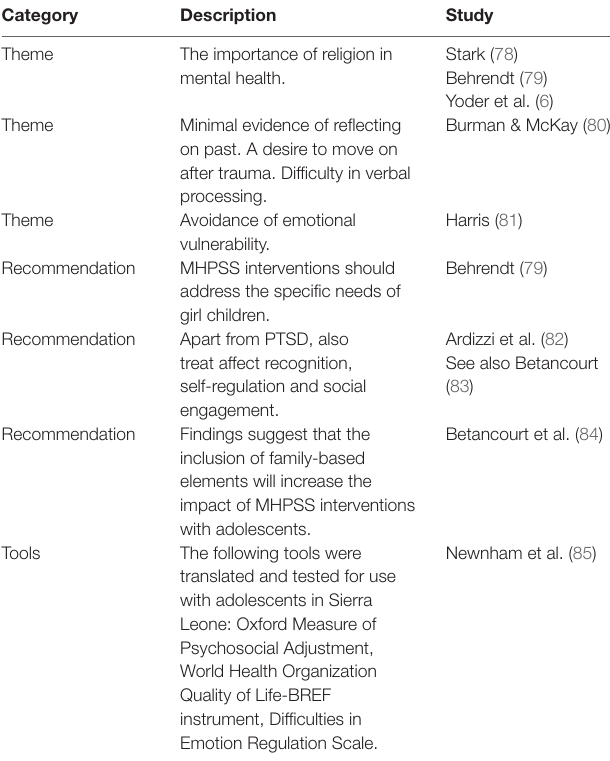
TABLE 1 | Examples of relevant themes, tools, and